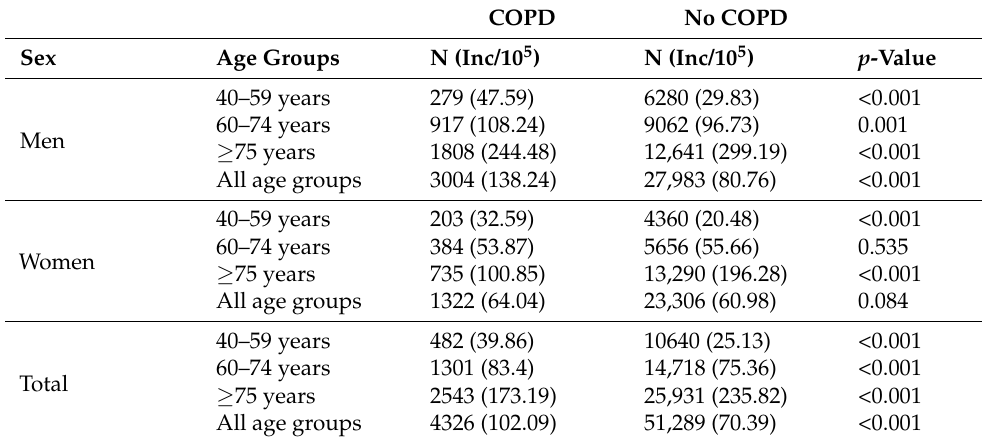
Table 1. Incidence of HS according to presence of COPD, sex and age